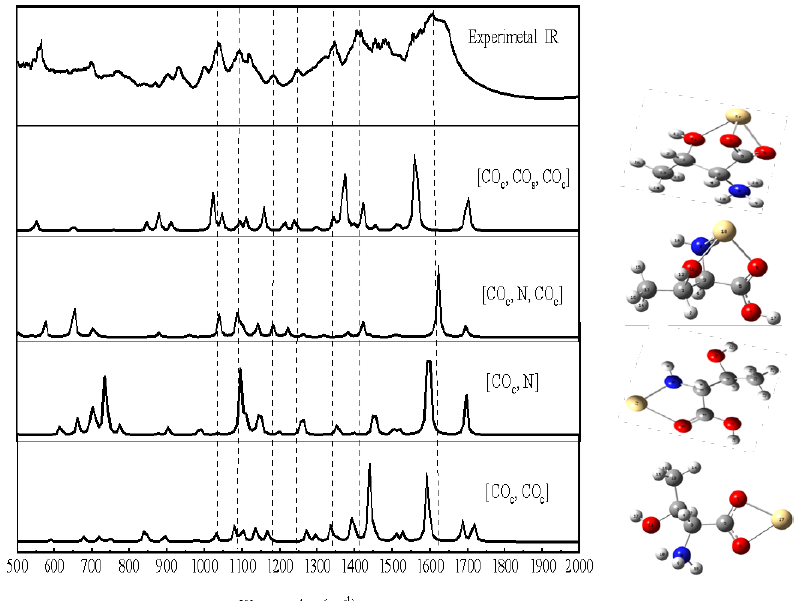
Figure 3. The experimental (upper) and calculated (lower) IR spectra of ThrCd 2+ . The gray, red, yellow, blue, and silver balls represent carbon, oxygen, cadmium, nitrogen, and hydrogen atoms, respectively.